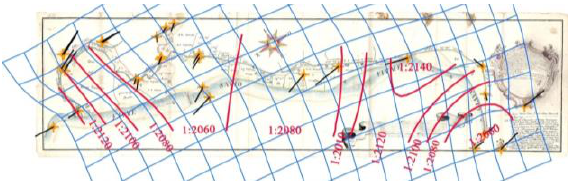
Figure 9. Graphic result of the deformation analysis on the map of Figure 5: GCPs with vector errors (black, exagg. factor 5), Gauss-Boaga distortion grid (blue, mesh size 200 m, exagg. factor 5), scale isolines (magenta, interval 22.5